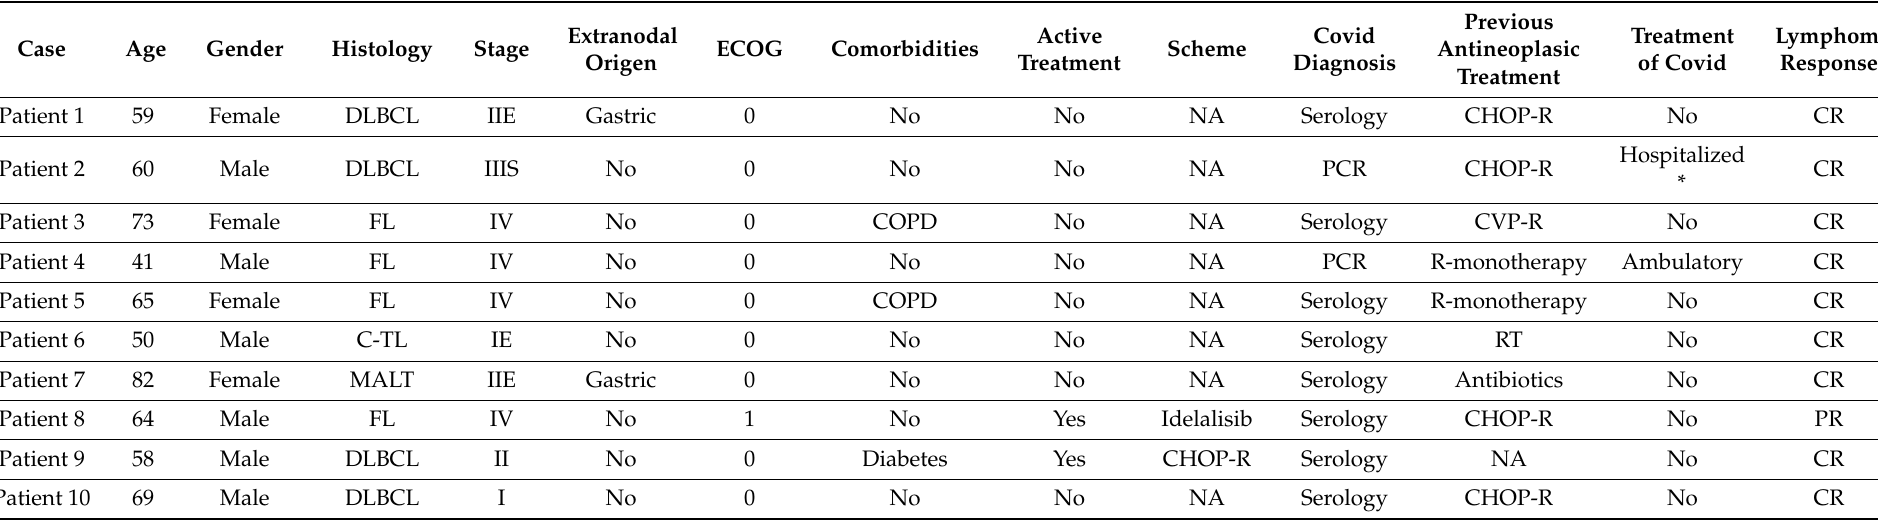
Table 3. Clinical characteristics of patients with positive serology (IgG) of